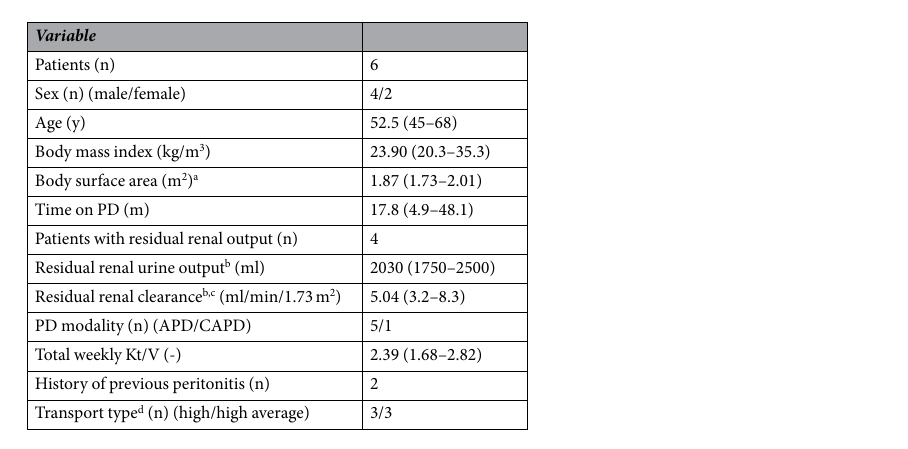
Table 1. Baseline characteristics of the pilot RCT study population. Data are presented as median (range). Body surface area was calculated with the Du Bois method. b Median residual renal urine output and clearance were computed from 4 patients with residual renal output. c Residual renal clearance was calculated as mean of renal creatinine and renal urea clearance using 24 h urine samples. d Transport type was determined from the PET with standard 3.86%